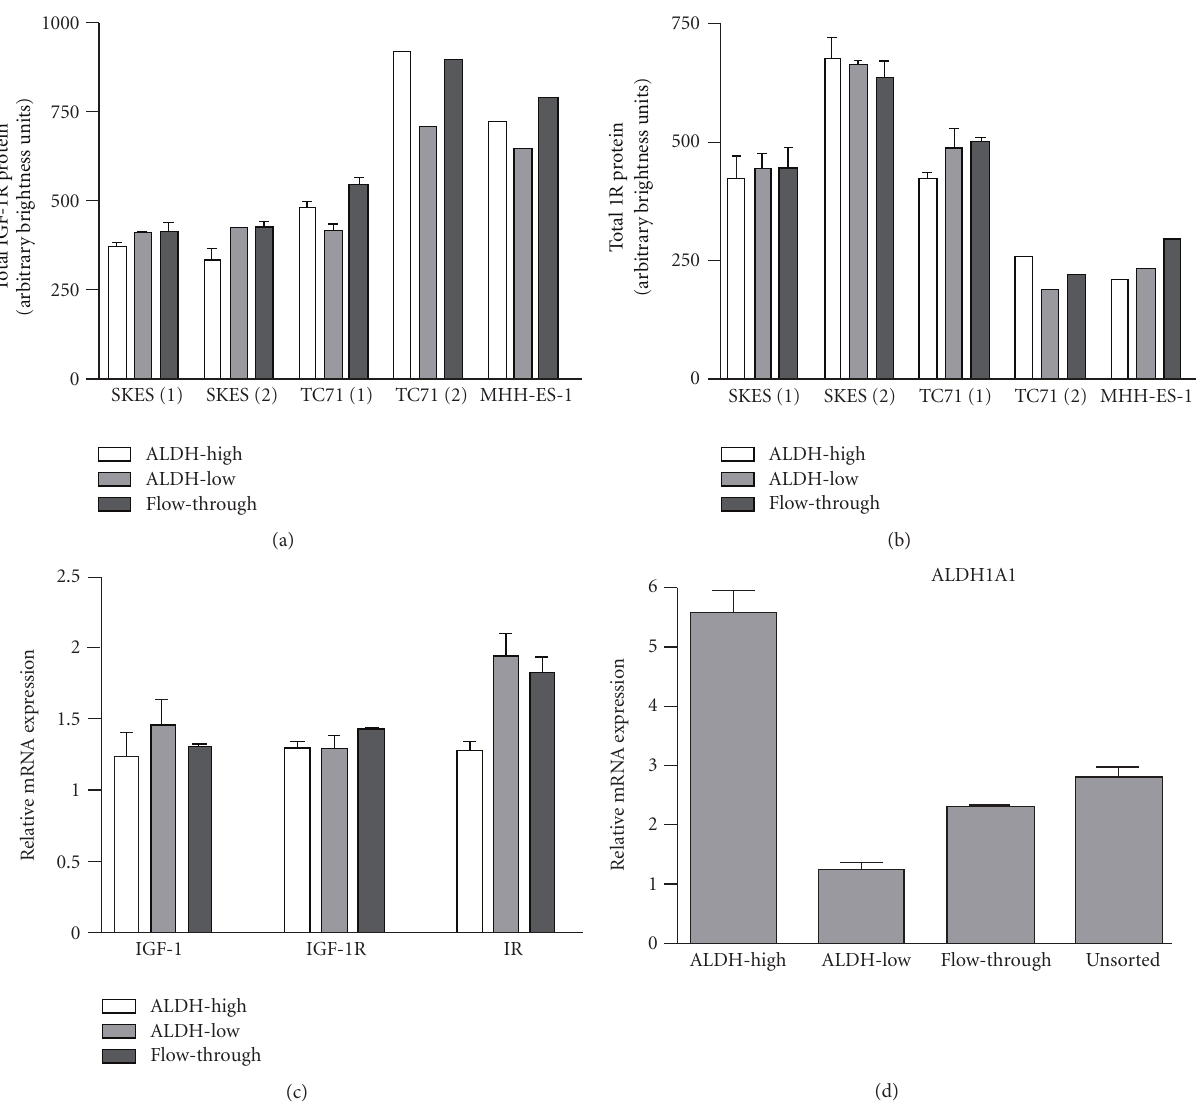
F 5: �otal expression of IGF-1R pathway members in ES cell lines. (a) Luminex x�A� quanti�cation of total IGF-1R protein in AL�H- sorted ES cells. (b) Luminex x�A� quanti�cation of total IR protein in AL�H-sorted ES cells. (c) qR�-�CR quanti�cation of IGF-1, IGF-1R, and IR mR�A transcripts in AL�H-sorted �C71 cells. (d) �uanti�cation of AL�H1A1 mR�A in Alde�uor-sorted �C71 cells. �umbers in parentheses refer to replicate